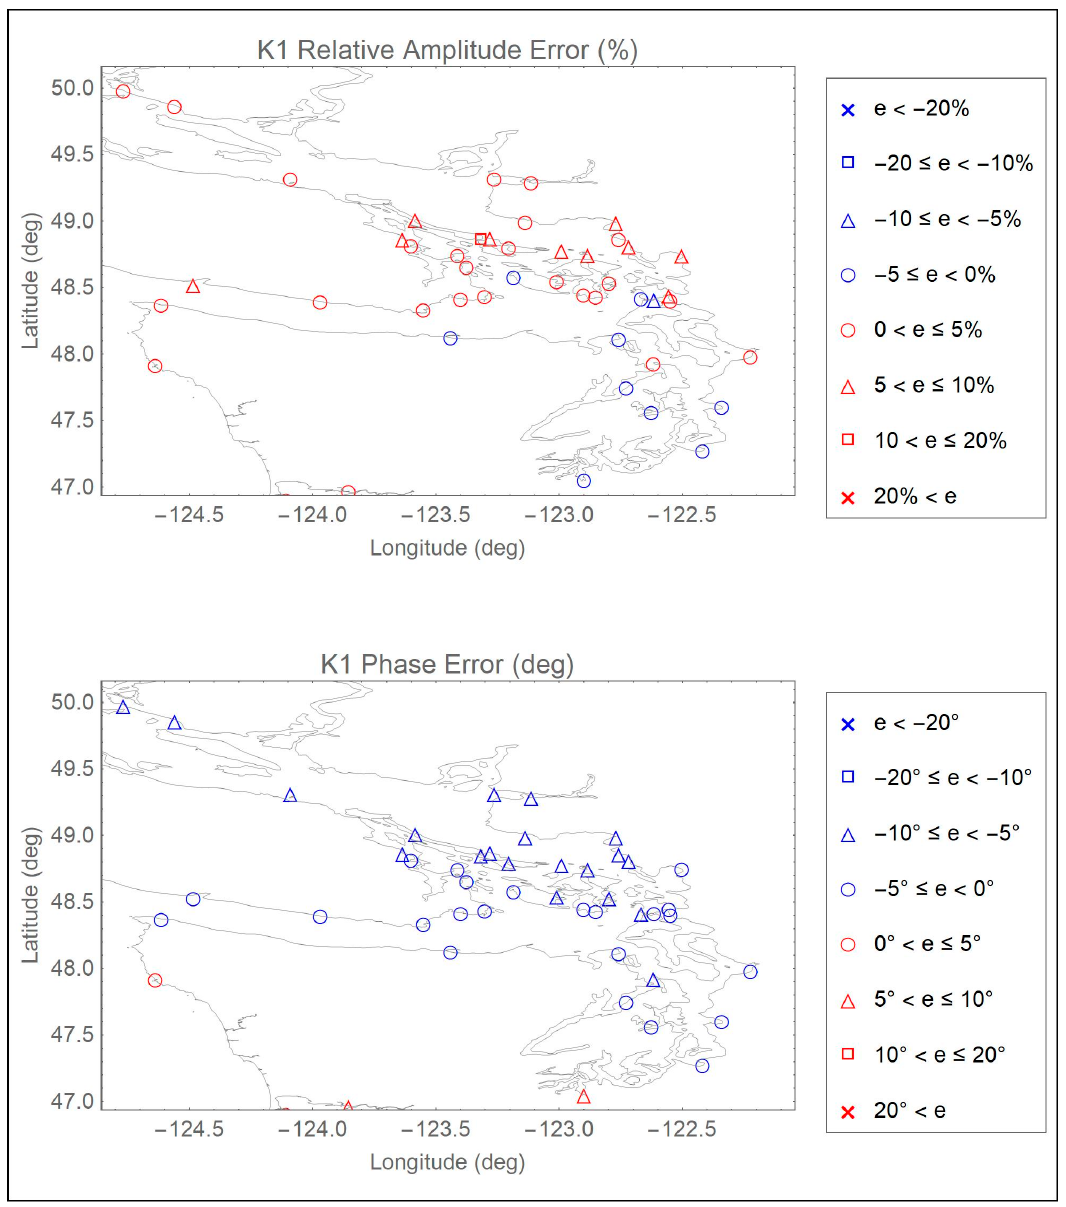
Figure A20. Distribution of ENPAC15 relative amplitude (%) and absolute phase (deg) errors for the K 1 constituent: Puget Sound view.